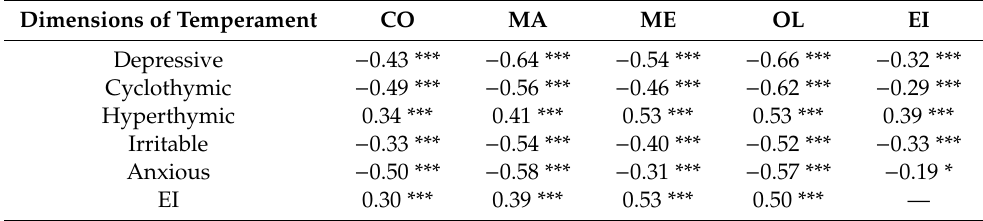
Table 2. Correlation between dimensions of temperament, dimensions of sense of coherence (SOC), and EI (N = 173).